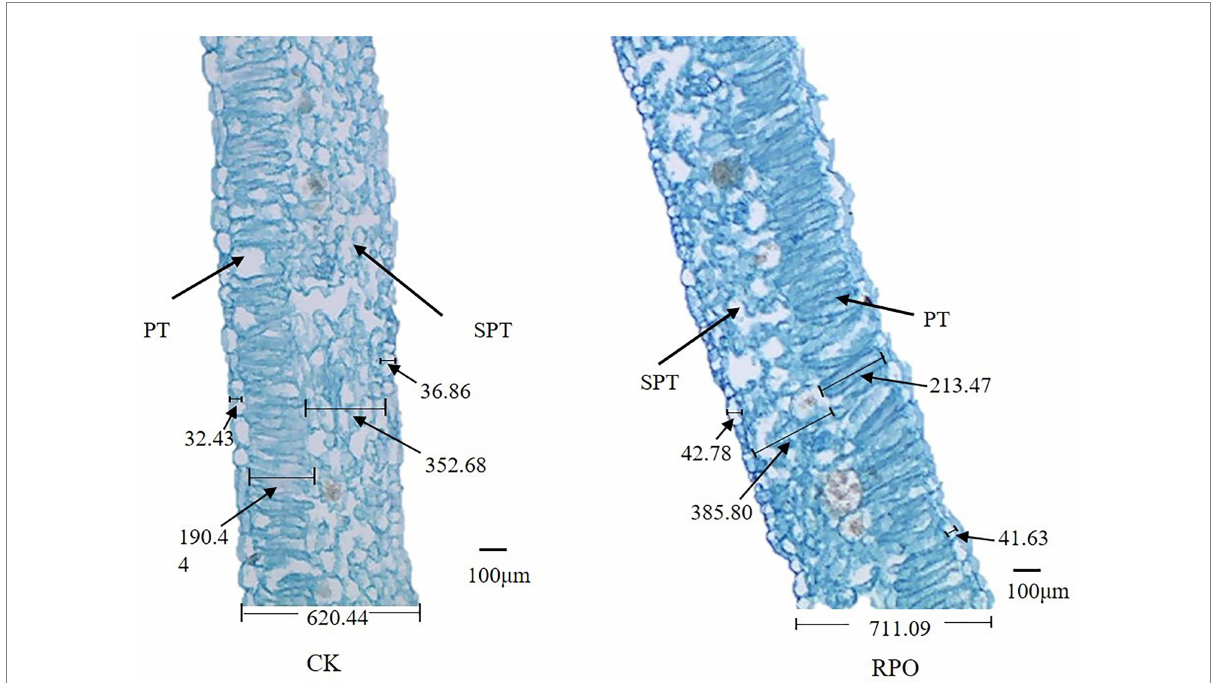
FIGURE 2 Effect of RPO film on the structure of sweet pepper functional leaves. SPT: spongy tissue; PT: palisade tissue.